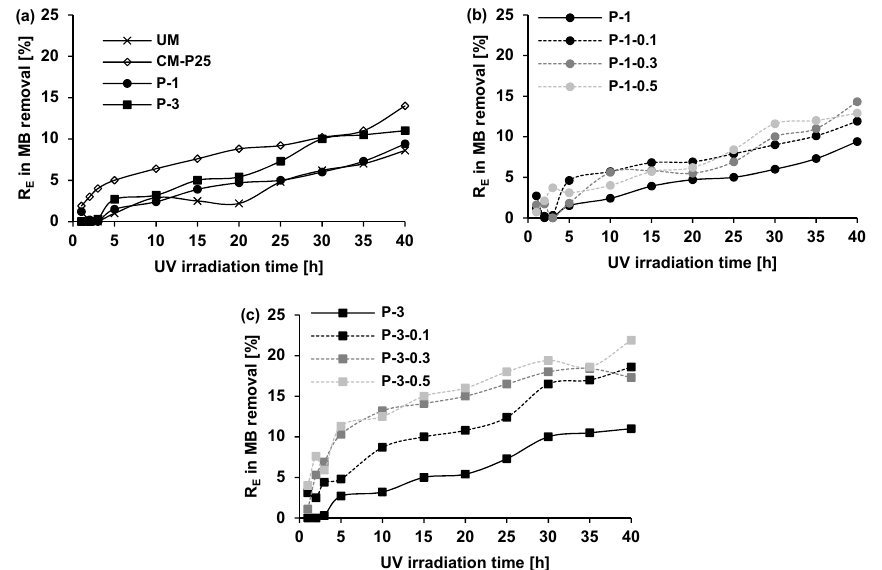
Figure 3. Photocatalytic degradation of Methylene Blue (MB) dye from gypsum surface as a function of UV irradiation time. ( a ) UM-unmodified gypsum plaster; CM-P25 gypsum plaster with 1wt%TiO 2 -P25; P-1, P-3 gypsum plaster with 1 and 3wt.% of TiO 2 /N; ( b ) P-1 gypsum plaster with 1 wt.% of TiO 2 /N; P-1-0.1, P-1-0.3, P-1-0.5 gypsum plaster with 1 wt.% of TiO 2 /N and 0.1, 0.3, 0.5 wt.% of glass fiber, respectively; ( c ) P-3 gypsum plaster with 3 wt.% of TiO 2 /N; P-3-0.1, P-3-0.3, P-3-0.5 gypsum plaster with 3 wt.% of TiO 2 /N and 0.1, 0.3, 0.5 wt.% of glass fiber, respectively.